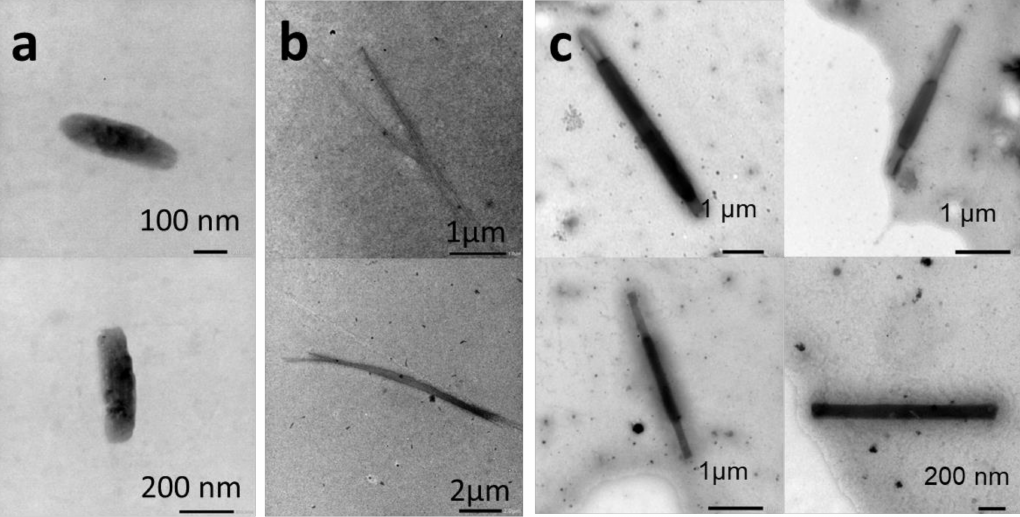
Figure 5. TEM images of the self-assembled structures obtained after micellization and thermal annealing: Images ( a – c ) correspond to samples 3a, 3c, and 3d,